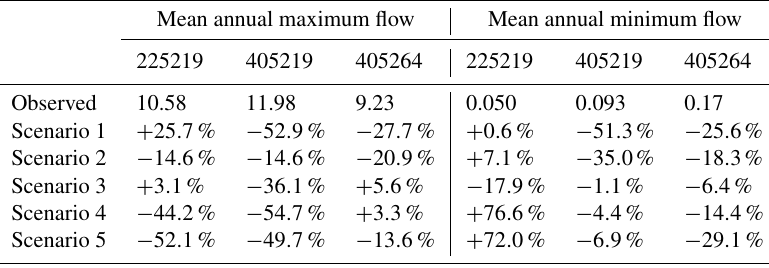
Table 6. Comparison of the projection performance of median flows during the verification period associated with the mean annual maximum in the dry years. The percentage represents the percentage variation between the modeled value and the observed value.